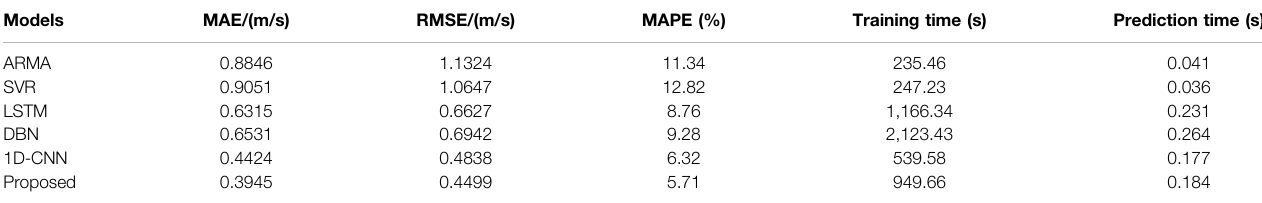
TABLE 1 | Wind speed prediction results of different prediction